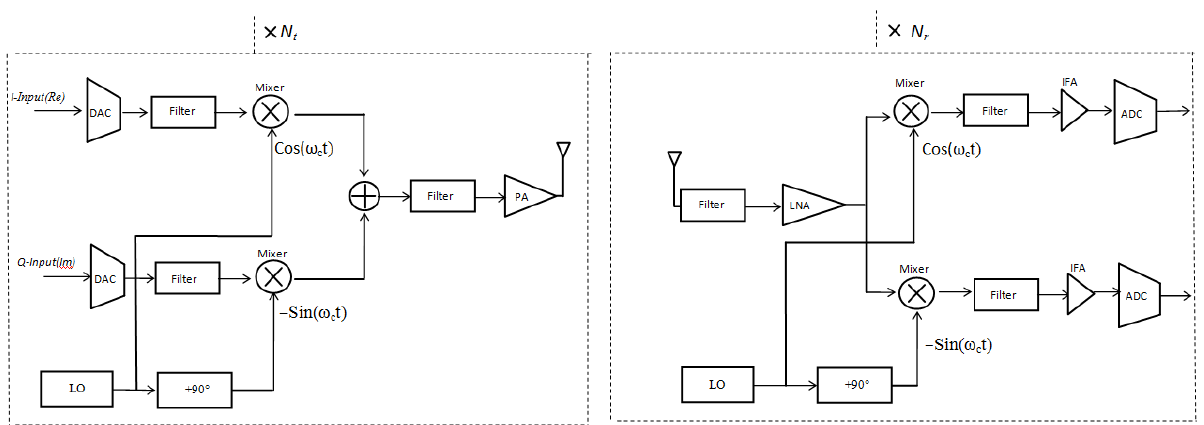
Figure 6. Transmitter and receiver architecture (In-Phase/Quadrature-Phase) for FOFDM, QAM, DQPSK, and OQPSK